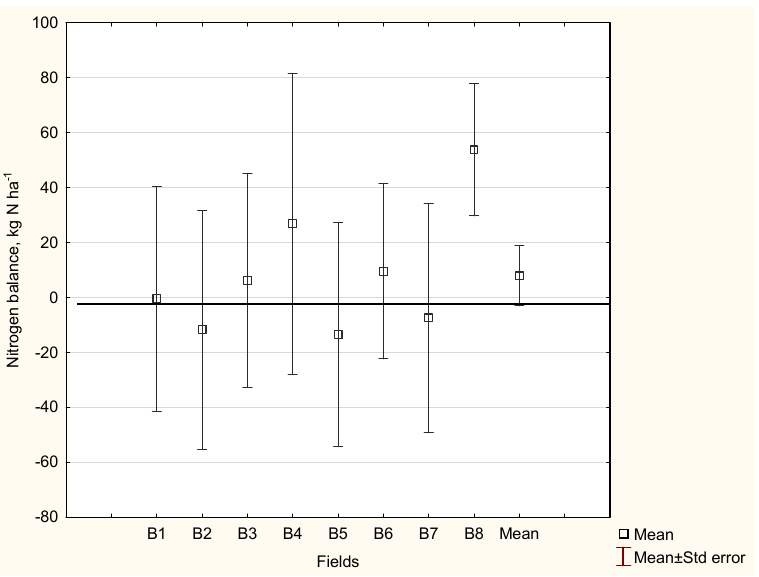
Figure 7. The simplified nitrogen (N) balance for a mixed farm in Poland. Legend: N input included: N f —fertilizer nitrogen N fym1-3 —amount of nitrogen delivered form manure in three consecutive years following application date and N CRs —nitrogen in crop residues; N output included N Y —nitrogen accumulated in the yield.